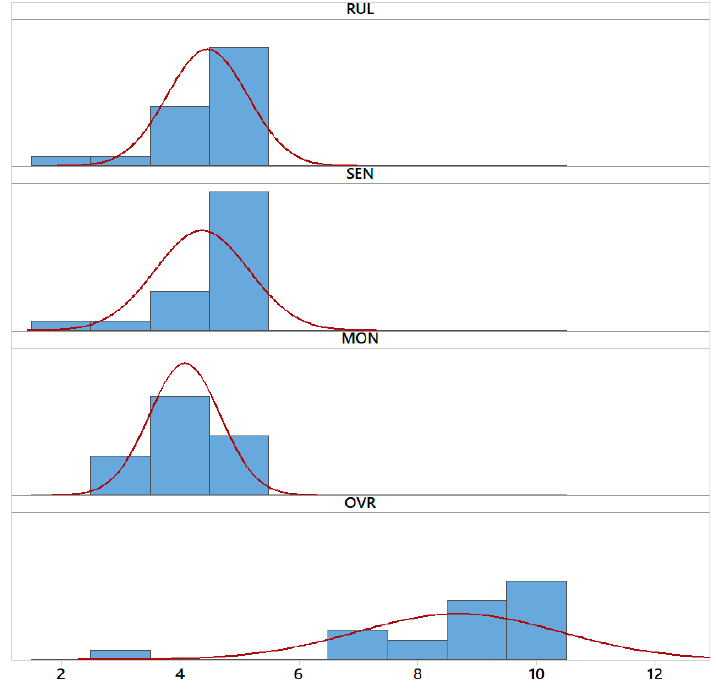
Figure 16. Distribution of data for the four dependent variables.